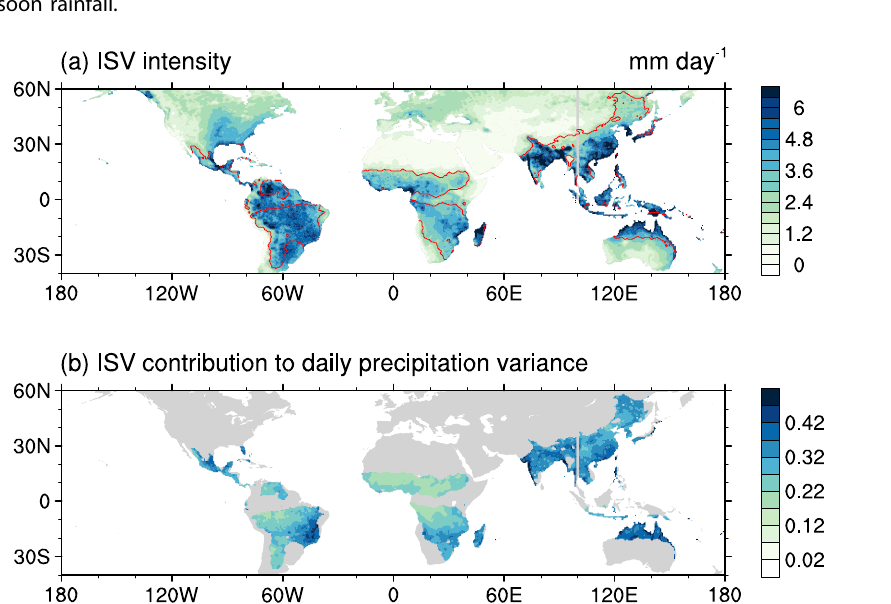
Fig. 1 Climatological ISV activity in monsoon seasons during 1979 – 2018. a is summer (MJJAS for NH and NDJFM for SH) ISV intensity (mm day − 1 ) de fi ned by the standard deviation of 8 – 70-day bandpass- fi ltered precipitation anomalies. The global land monsoon regions are outlined by red lines, and the East Asian (EA) and South Asian (SA) regions are separated by the gray line. A monsoon region is de fi ned as the region where the local summer-minus-winter precipitation exceeds 300 mm, and the summer precipitation exceeds 55% of the annual total 103 . b shows the 8 – 70-day ISV variance contribution to the total daily precipitation variance. The contribution is calculated by the ratio of the averaged power spectrum in the intraseasonal band to the total power. The area-conserving format is used in which the variance is proportional to the area of the logarithm of frequency versus power times frequency.